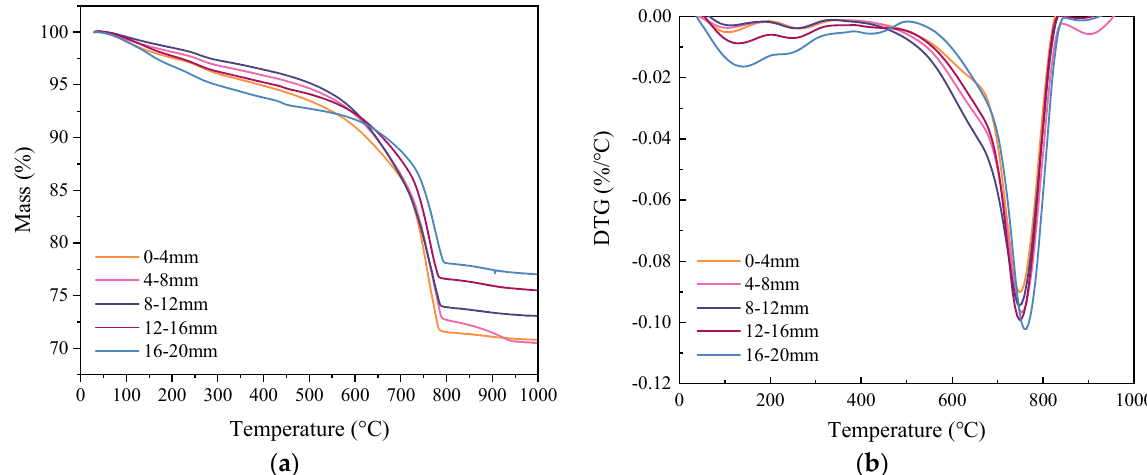
Figure 6. Results of ( a ) TG and ( b ) DTG at various depths.